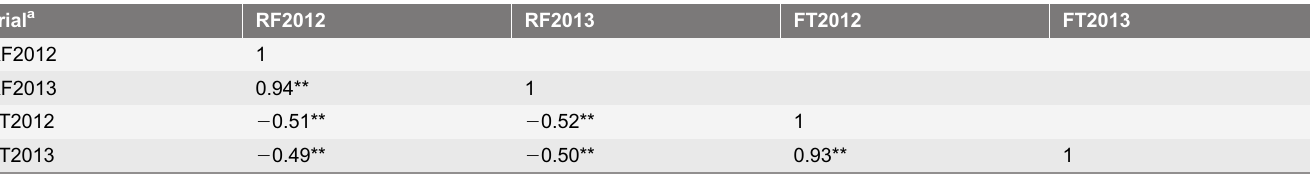
Table 2. Correlation coefficients of brittle rachis and threshability in Triticum aestivum ssp. tibetanum Shao population from accessions Q1028 6 ZM9023. Trial a RF2012 RF2013 FT2012 FT2013 RF2012 1 RF2013 0.94** FT2012 2 0.51** 2 0.52** 1 FT2013 2 0.49** 2 0.50** 0.93** 1 **Indicates significant levels at p , 0.01. a For brittle rachis, the two trials conducted were designated as RF2012 and RF2013. For threshability, the two trials conducted were designated as FT2012 and FT2013.